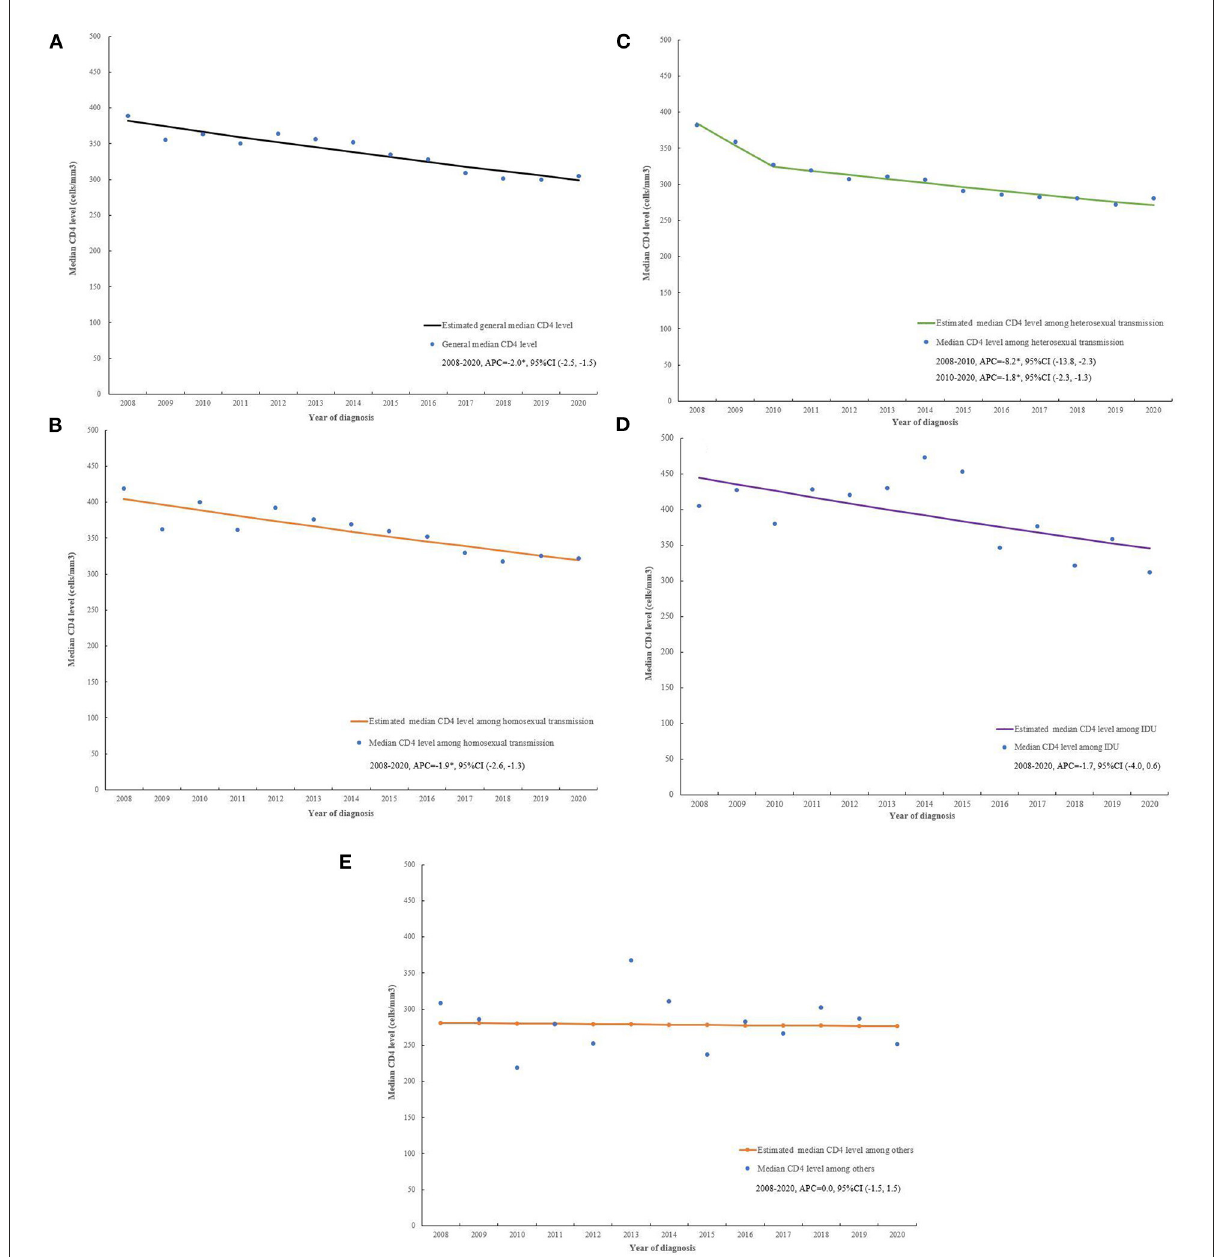
FIGURE4 The trends of median CD4 level for general (A) , homosexual transmission (B) , heterosexual transmission (C) , IDU (D) , and others (E) from 2008 to 2020, in Jiangsu, China. APC, annual percentage change; CI, confidence interval; * P < 0.05.